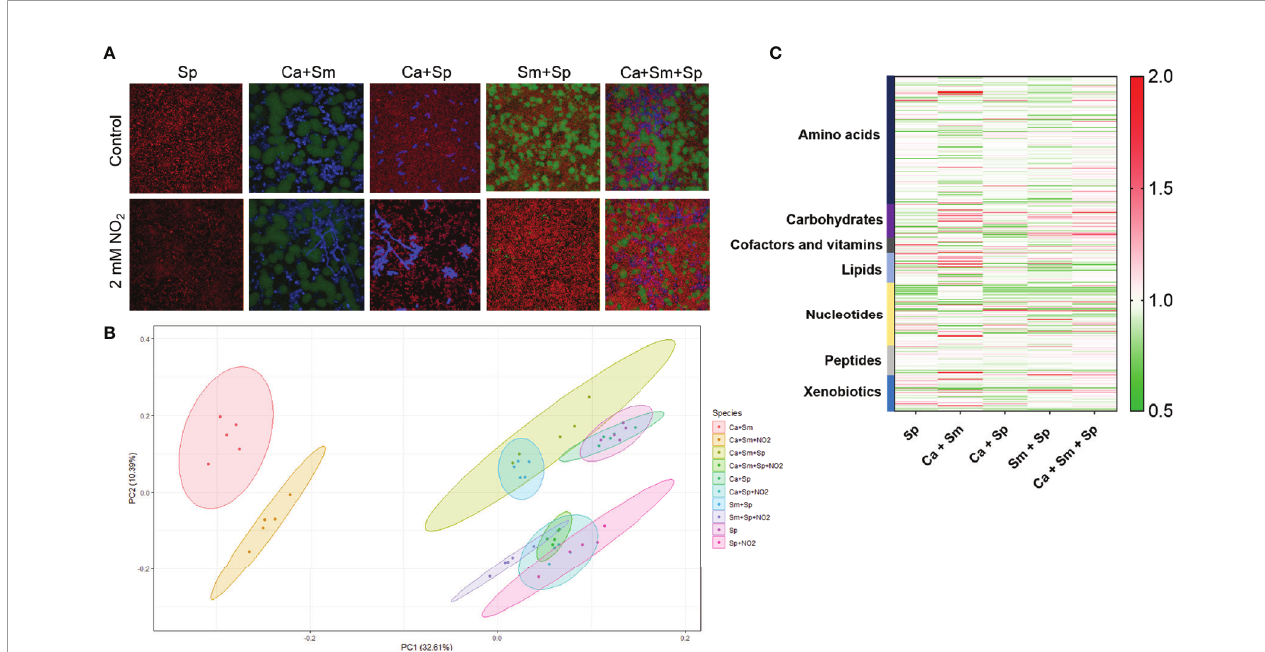
FIGURE 2 | S. parasanguinis and nitrite reprogram the metabolic signature of oral polymicrobial bio fi lms (A) . Confocal scanning laser microscopy images of S. parasanguinis (Sp), S. mutans (Sm), C . albicans (Ca) in mixed bio fi lms at 60X magni fi cation. S. mutans was labeled with green fl uorescent protein (GFP), C. albicans was stained with calco fl uor white, and S. parasanguinis was labeled with mCherry. All bio fi lms were grown in tryptic soy broth containing 0.5% yeast extract (TSBYE) and 1% sucrose (+/- 2mM NO 2 ) for 16 h at 37°C with 5% CO 2 . (B) Principal Component Analysis of single (Sp only) and dual and triple species bio fi lms. (C) Global metabolomics pro fi ling of dual- and tri-species cultures and single-species S. parasanguinis cultures. Metabolomics data were collected for 5 replicates in each group.